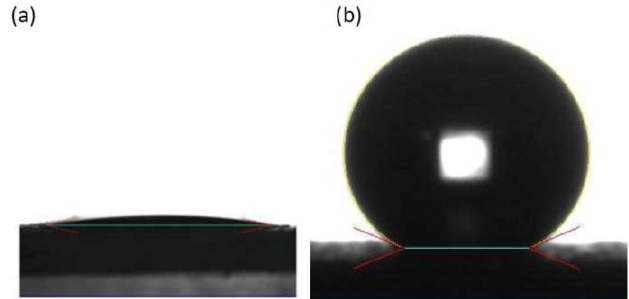
Figure 7. Water contact angle of water droplets on silica nanoparticles–based coating without ( a ) and with ( b ) POTS treatment.